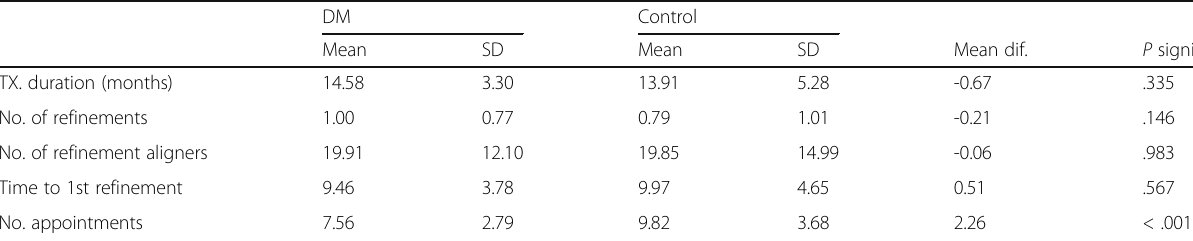
Table 2 Results